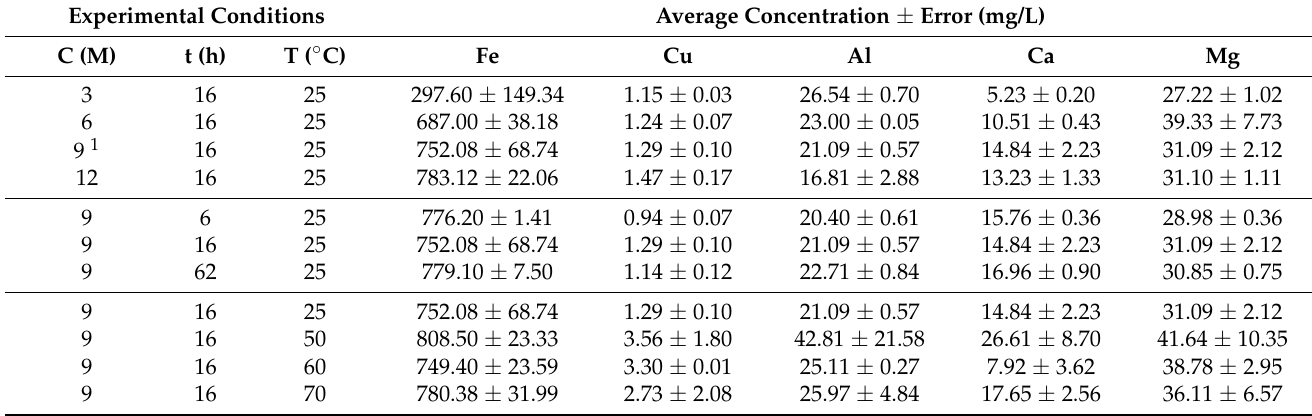
Table 1. Average concentration and standard error associated of the elements obtained.